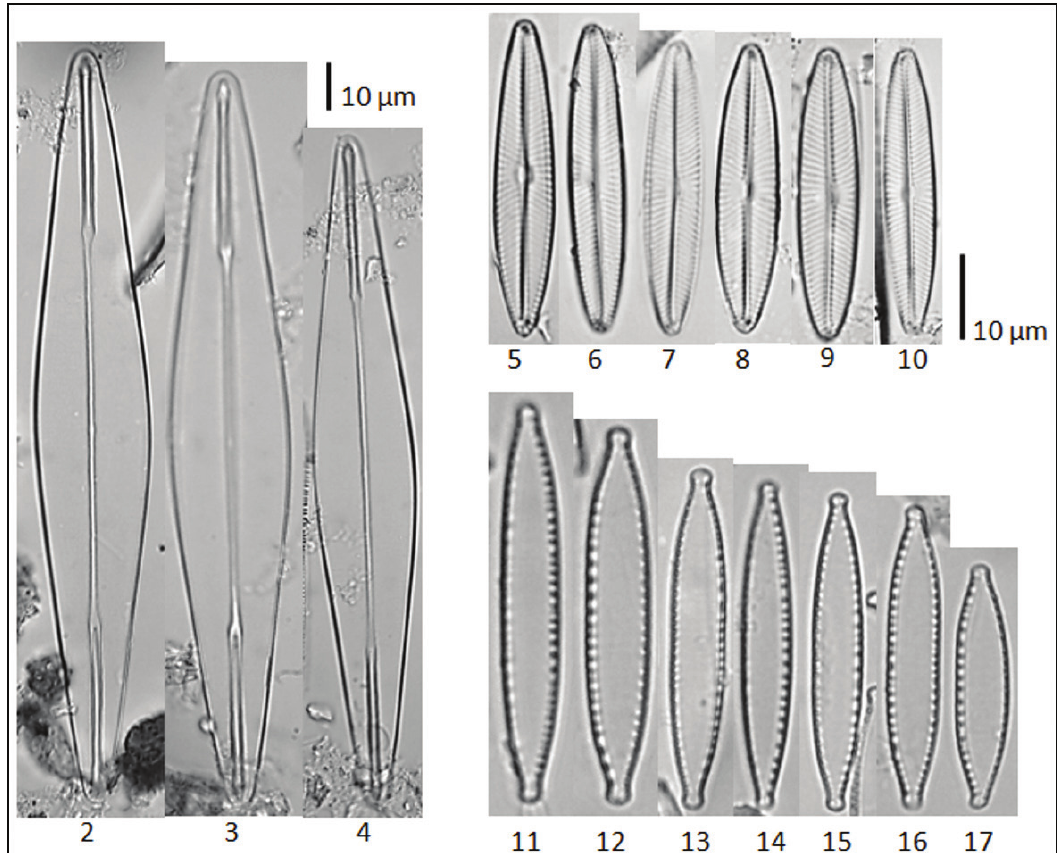
Figures 2-17. Abundant diatom species in the Andreas Stream Sub-basin, RS, Brazil. 2-4 : Amphipleura lindheimeri ; 5-10 : Navicula symmetrica ; 11-17 : Nitzschia palea